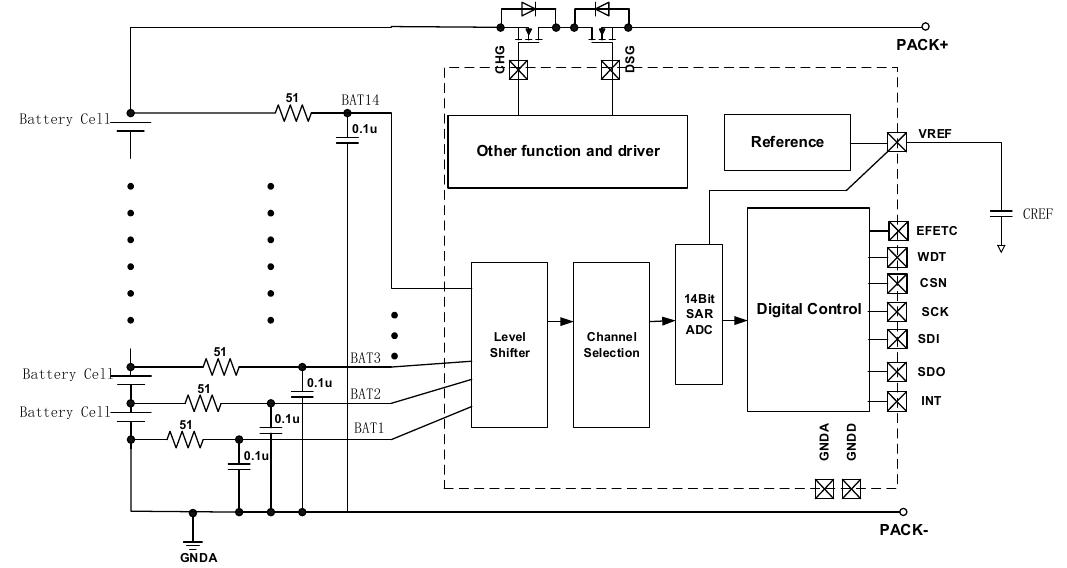
Figure 1. Application diagram of battery protection and monitor system.